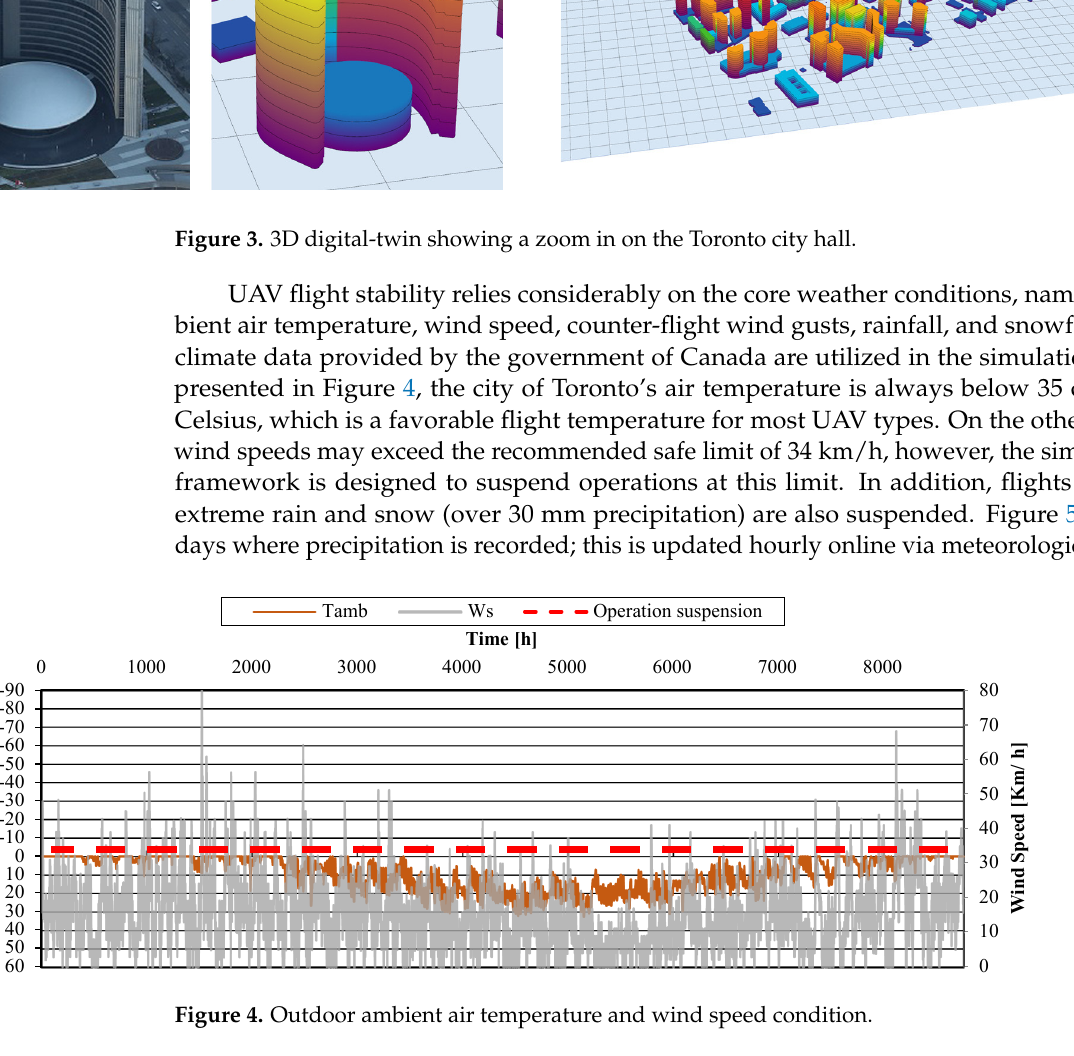
Figure 5. Total rainfall and snowfall in Toronto city.